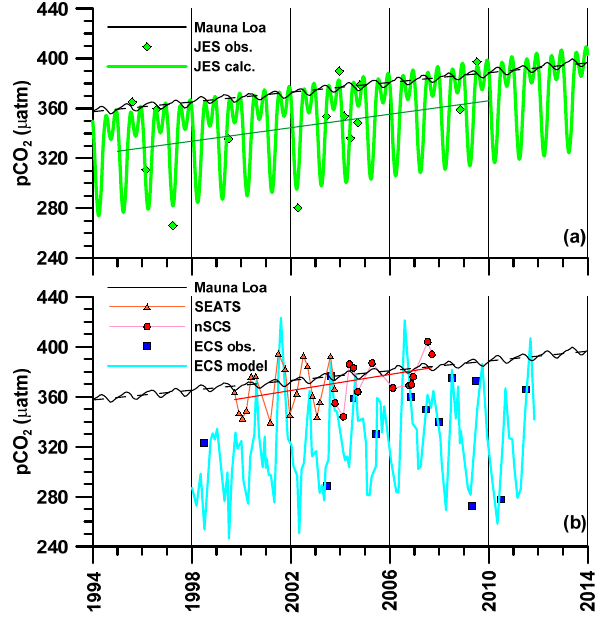
Figure 2. Observed partial pressure of CO 2 in surface waters of the three marginal seas examined in this special issue, namely, (a) the Japan/East Sea (Kim et al., 2014), (b) the East China Sea (Tseng et al., 2011; 2014a) and the South China Sea (Tseng et al., 2007; Zhai et al., 2013). Also plotted are the pCO 2 in the air observed at Mauna Loa, Hawaii. Both the JES and the SCS show clear trend of increasing pCO 2 , while the ECS does not show a clear trend due to strong variability and insufficient measurements. (See text)